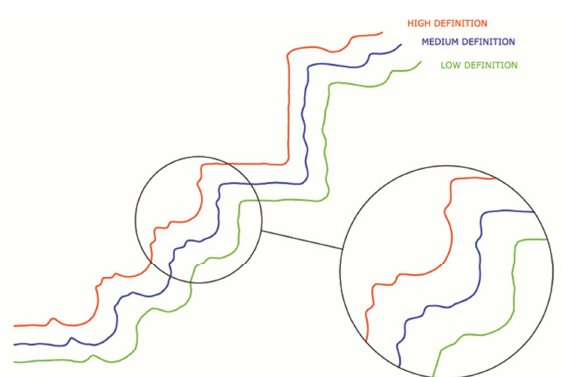
Figure 8. Assemini, San Pietro. Comparison between profiles of moldings obtained by sectioning the three mesh: High, Medium,